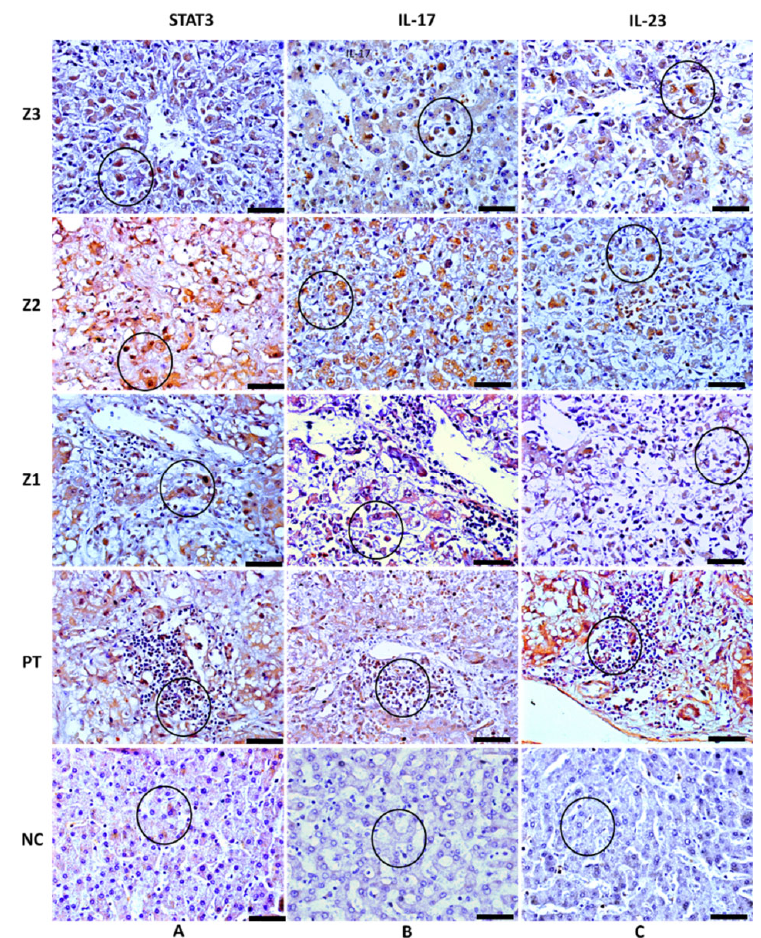
Figure 3. STAT3, IL ‐ 17A, and IL ‐ 23 positive immunohistochemistry staining in zones Z3, Z2, and Z1 and PT in the liver parenchyma of patients with fatal YF and normal controls. ( A ) Immunolabel ‐ ing for STAT3 in hepatocytes (circle) ( A ‐ Z3 , A ‐ Z2 , A ‐ Z1 ) and in the inflammatory infiltrate ( A ‐ PT ). ( B ) Immunolabeling for IL ‐ 17A in hepatocytes (circle) ( B ‐ Z3 , B ‐ Z2 , B ‐ Z1 ), and in the inflammatory infiltrate ( B ‐ PT ). ( C ) Immunolabeling for IL ‐ 23 in hepatocytes (circle) ( C ‐ Z3 , C ‐ Z2 , C ‐ Z1 ) and inflam ‐ matory infiltrate in ( C ‐ PT ). Light marking for STAT3 in Z2 and preservation of the hepatic paren ‐ chyma (Circle) ( A ‐ NC ), absence of marking for IL ‐ 17A and IL ‐ 23, and preservation of the hepatic parenchyma (circle) ( B ‐ NC , C ‐ NC ). Magnification: 400× (scale bar, 20 μ m) . Z3: Pericentral zone; Z2: Midzonal zone; Z1: Periportal zone; PT: Portal tract. (Patient